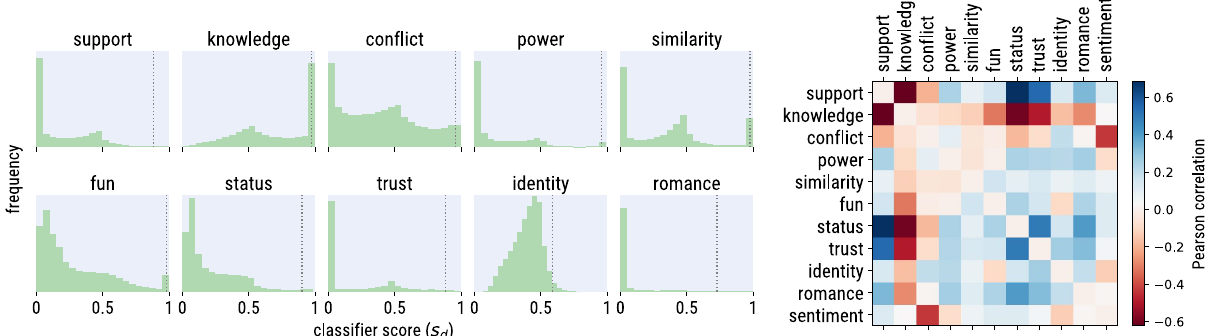
Figure 3. Left: frequency distributions of the classifier scores s d for all dimensions. The dotted vertical lines mark the values of the 99th percentile of each distribution. Right: cross-correlation matrix of the classifier scores of all dimension pairs across all messages, plus a simple measure of text sentiment.